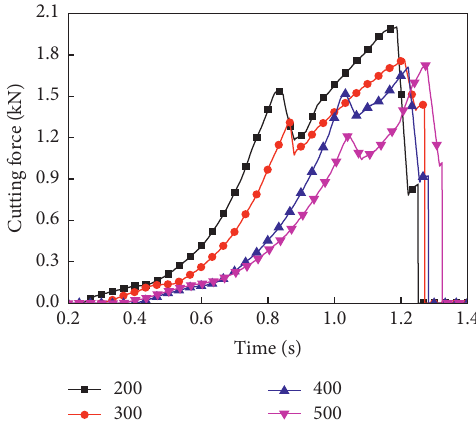
Figure 18: Variation in cutting force with time at different width. Table 5: The PFC with different width of rock plate. Width of rock plate (mm) 200